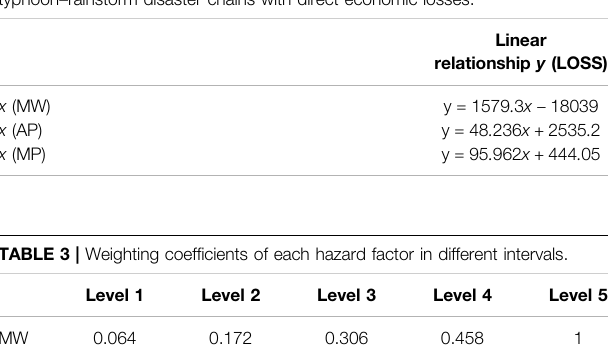
TABLE 2 | Linear relationships of hazard factors for typhoon – gale and typhoon – rainstorm disaster chains with direct economic losses.